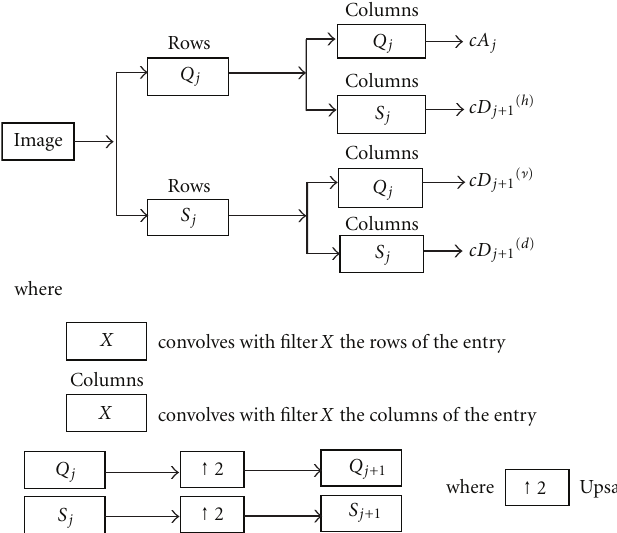
Figure 5: Decomposition steps of 2D SWT.